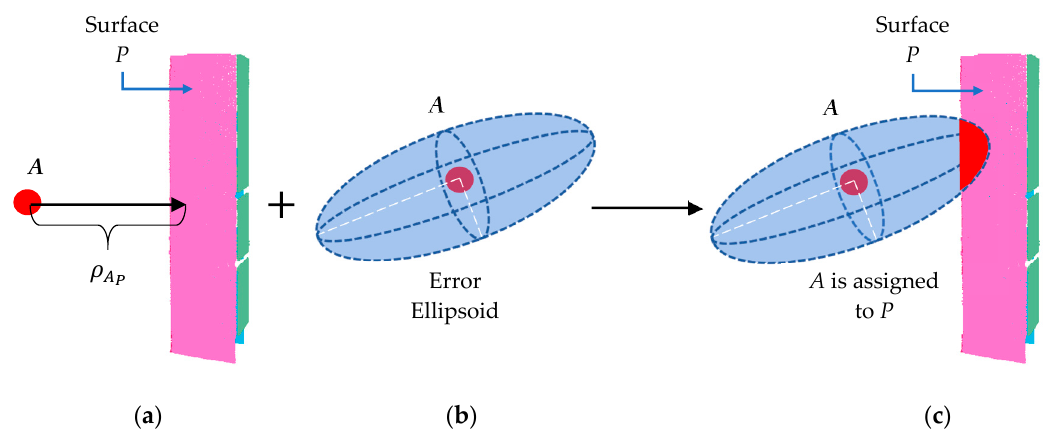
Figure 5. ( a ) Schematic representation of point A of a new scan and surface P , segmented from an old scan; ( b ) error ellipsoid around A ; ( c ) intersection of A with surface P as a means of assigning A to surface P .